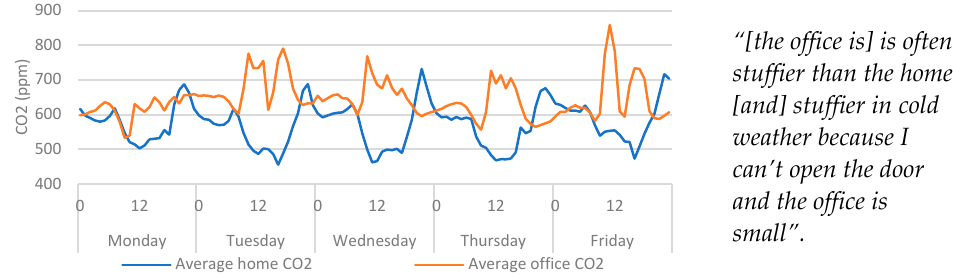
Figure 9. Average home/office CO 2 categorised by day > hour. Qualitative findings are displayed alongside the quantitative data for context.